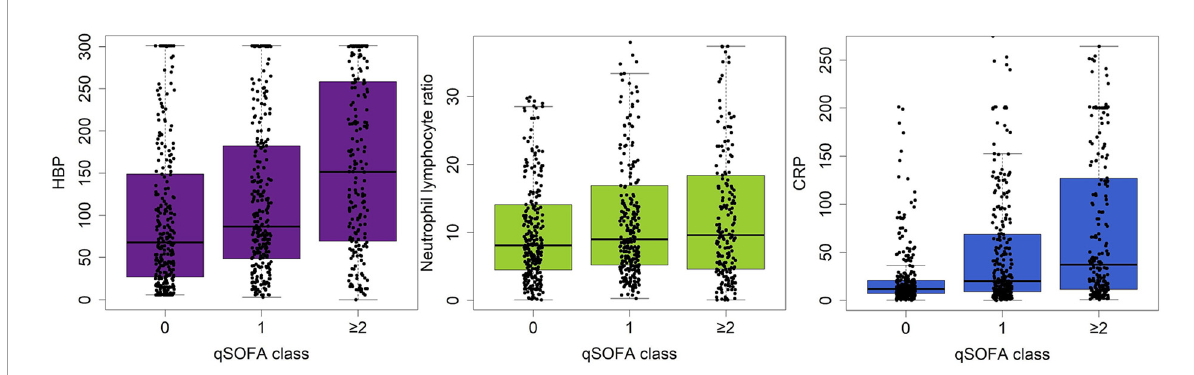
FIGURE2 Boxplot showing the correlation between serum levels of HBP, CRP and NLR and the qSOFA class (0, 1, ≥ 2). HBP has the highest correlation with qSOFA class, followed by CRP or